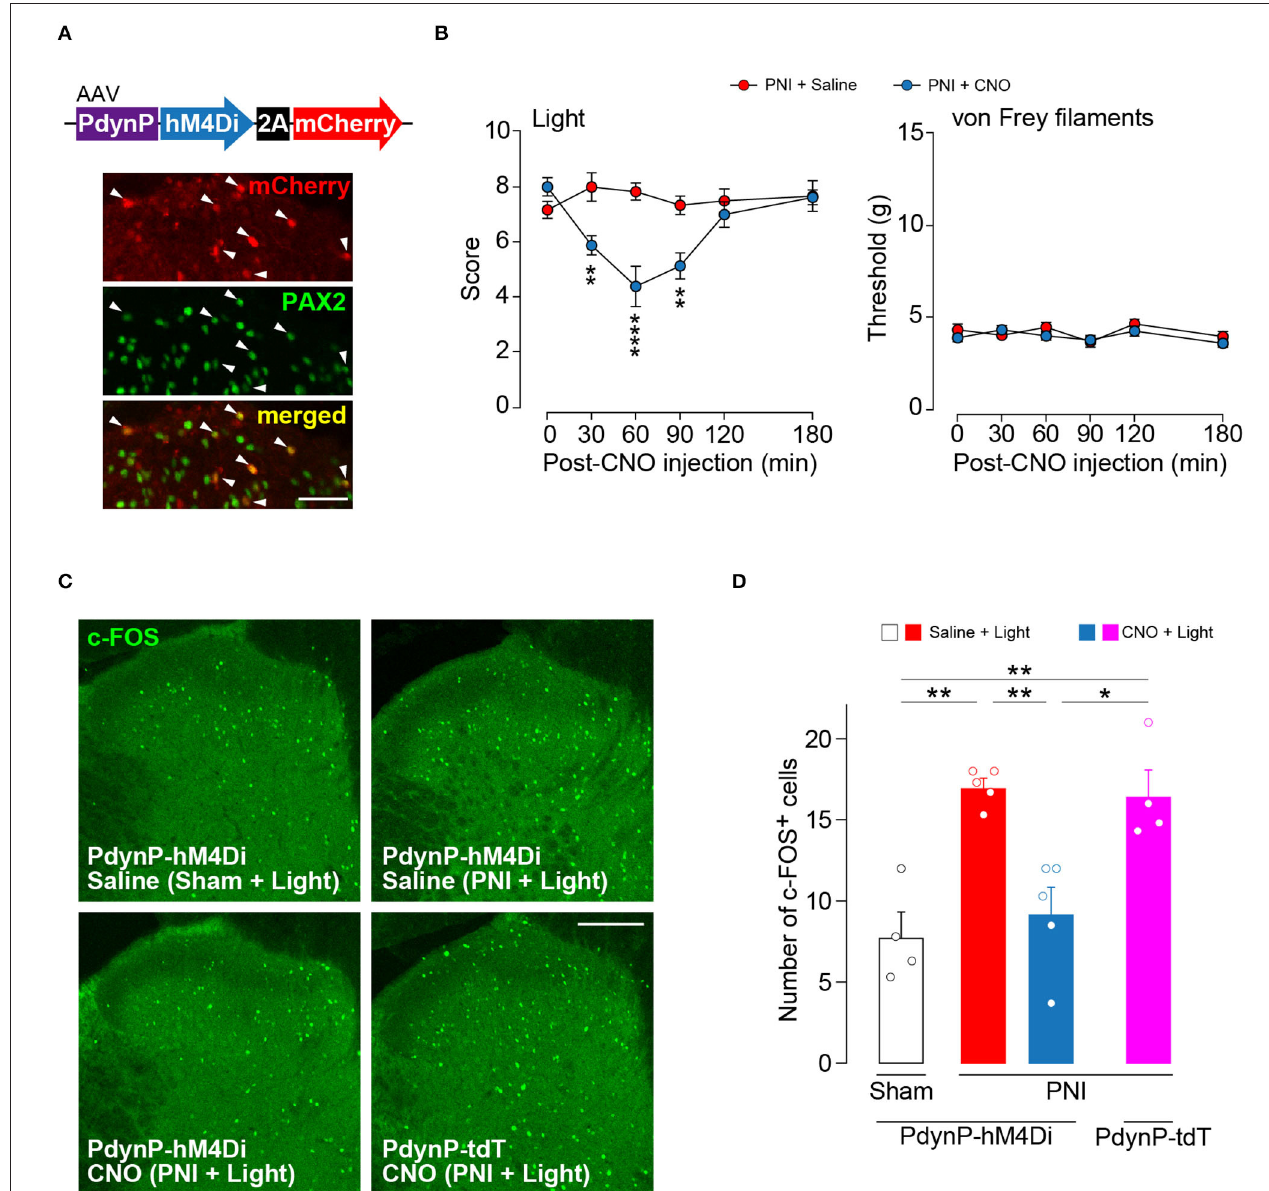
FIGURE 5 | Optogenetic A β fiber-induced pain-like behavior after peripheral nerve injury (PNI) was attenuated by silencing AAV-PdynP + neurons in rats. (A) Colocalization of mCherry and PAX2 (green) in the L4 spinal dorsal horn (SDH) at 4 weeks after intra-SDH microinjection of AAV-PdynP-hM4Di-2A-mCherry (indicated by arrowheads). Scale bar, 50 µ m. (B) Paw withdrawal behaviors from light and von Frey filaments before and after injection with the agonist CNO (1 mg/kg) or saline injection into W-TChR2V4 rats with PNI ( n = 6–8 rats). ** P < 0.01, and **** P < 0.0001, two-way repeated measures ANOVA with post-hoc Bonferroni multiple comparison test. (C,D) Immunofluorescence (C) and number (D) of c-FOS + neurons in laminae I–II of the L4 SDH of W-TChR2V4 rats with light stimulation 2 weeks after sham operation or PNI ( n = 4–5 rats). Scale bar, 200 µ m. * P < 0.05, and ** P < 0.01, one-way ANOVA with post-hoc Bonferroni multiple comparison test. Data shown as mean ±